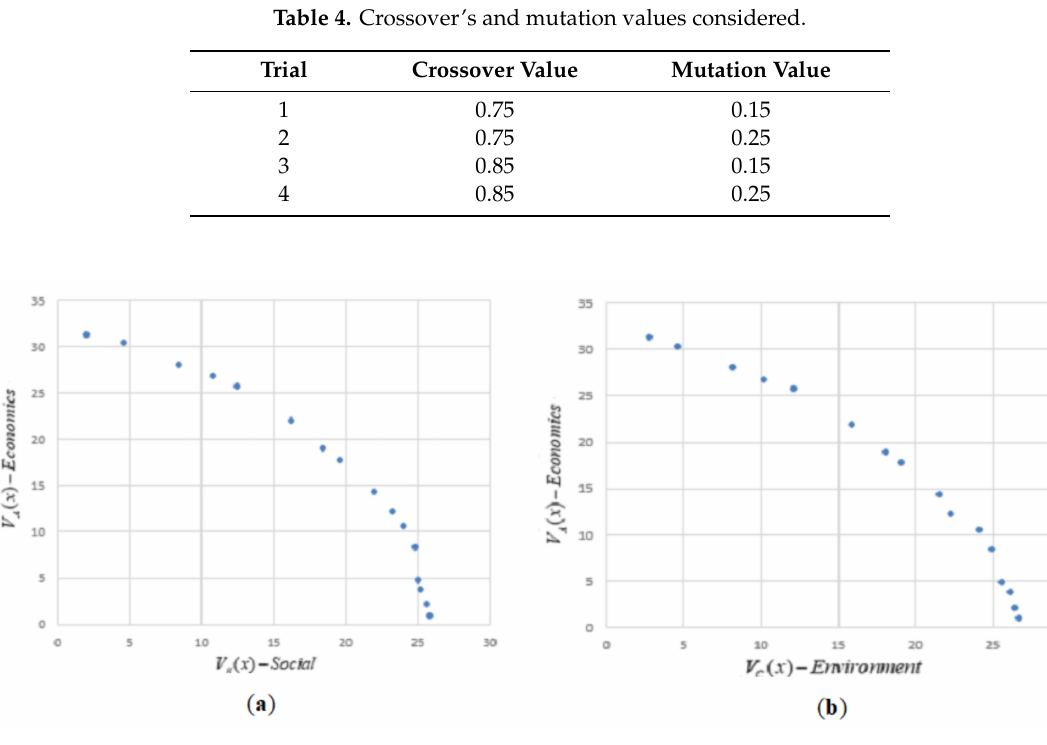
Figure 8. Pareto frontier: ( a ) ( ω A = 0.65; ω B = 0.35; ω C = 0.00); ( b ) ( ω A = 0.65; ω B = 0.00; ω C =